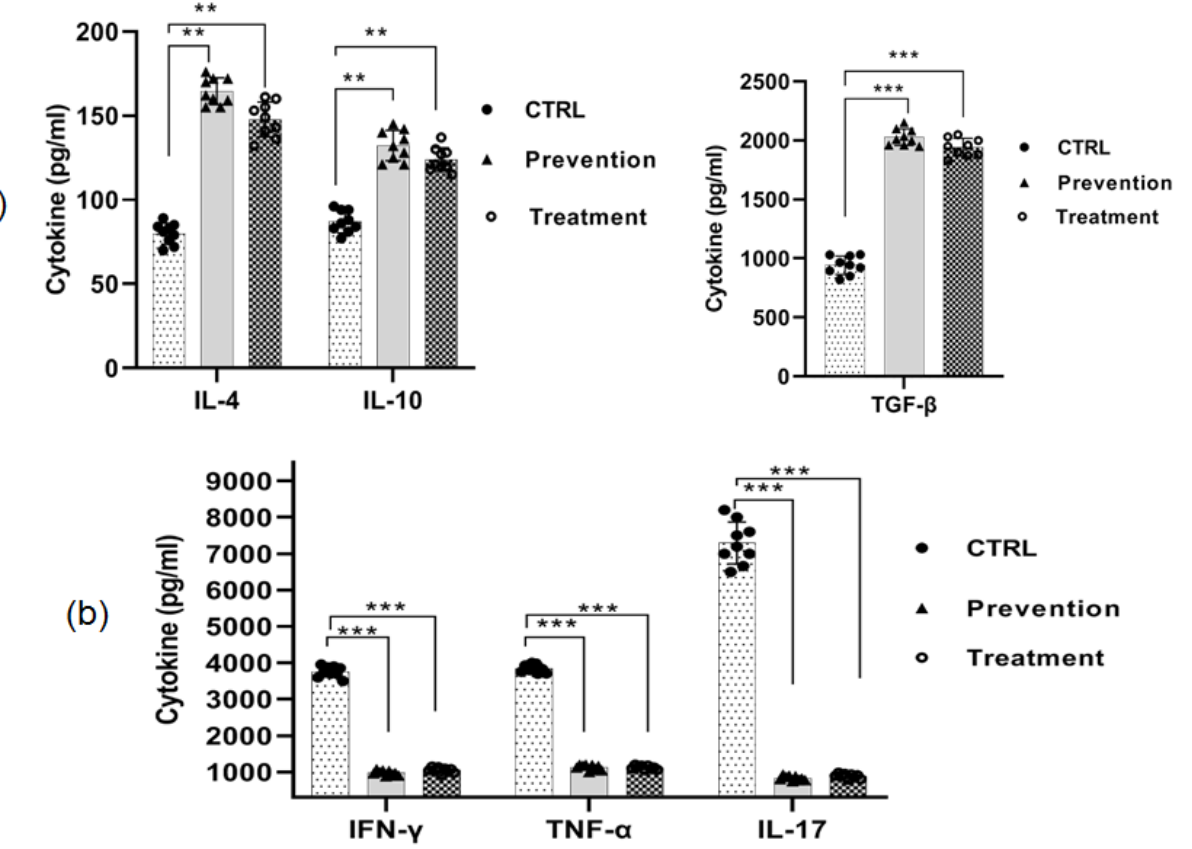
Figure 4. Oral administration of MOG suppressed pro-inflammatory cytokines production and enhanced anti-inflammatory cytokines production in splenocytes and lymph nodes from EAE mice. Splenocytes and lymph nodes from immunized mice from all groups were isolated on day 25 post- immunization and re-stimulated with MOG35–55 (20 µ g/mL) for 72 h. Cell culture supernatants were collected and indicated cytokine levels were measured by ELISA. Cytokine assays were conducted in duplicate wells. ( a ) Anti-inflammatory cytokines IL-4, IL-10, and TGF- β ; ( b ) pro-inflammatory cytokines IFN- γ , TNF- α , and IL-17 released by splenocytes in culture, ± SEM. Results from lymph nodes were similar to splenocytes. ** p < 0.01, *** p < 0.001, when compared with control group. Mice were divided into three groups: 1. Control group (CTRL, n = 9); 2. Prevention group with MOG (n = 9); 3. Treatment group with MOG (n =